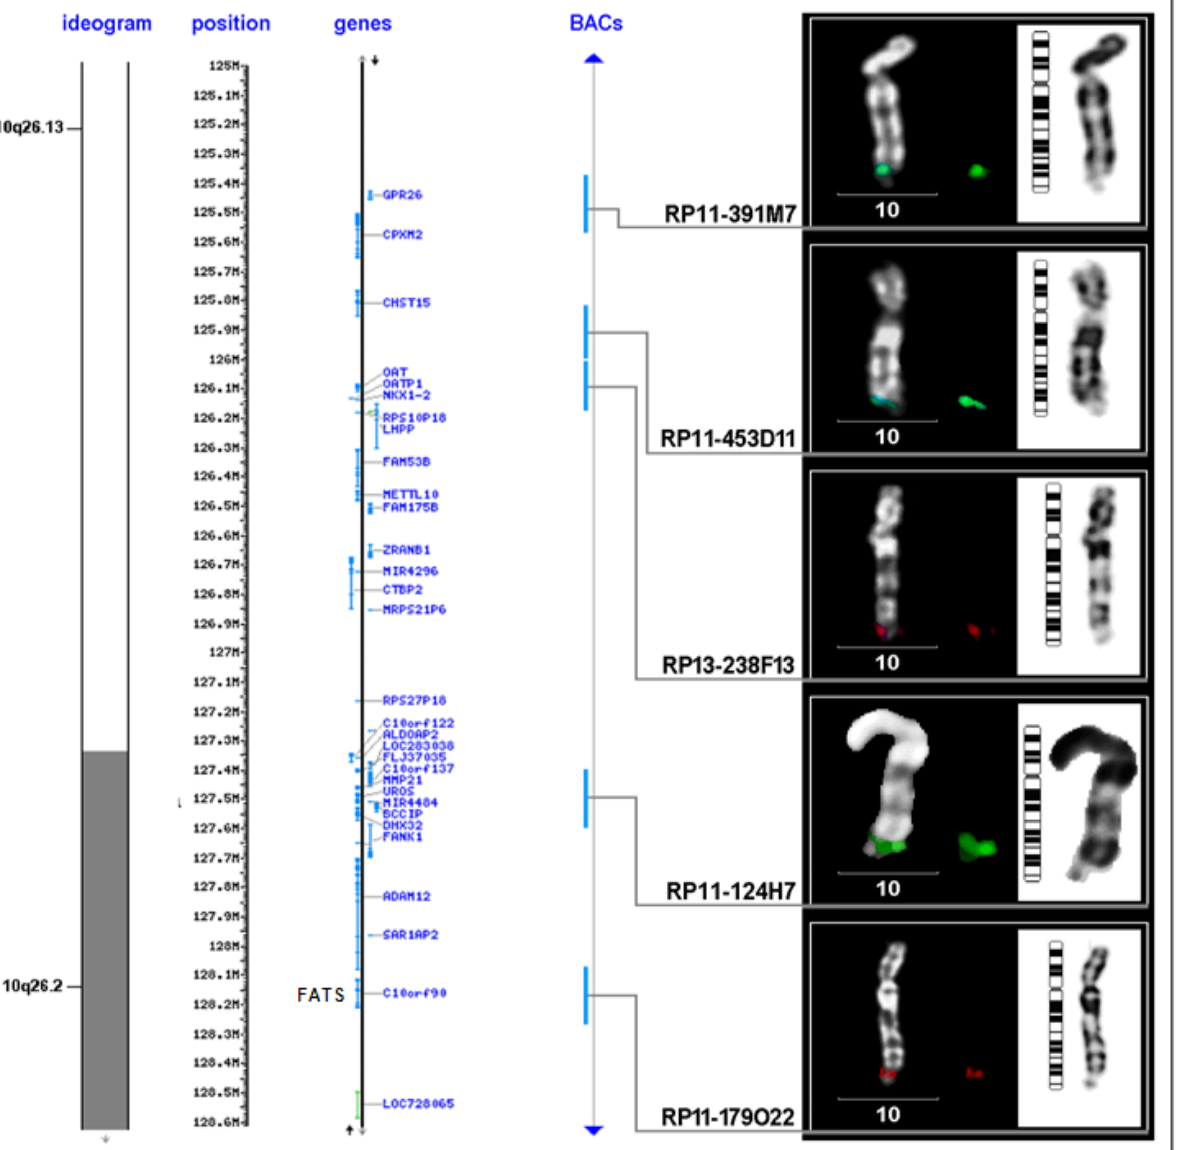
Figure 2. Mapping of FRA10F by FISH. The indicated BAC DNA was labeled and subjected to FISH analysis. The associated genes including FATS ( C10orf90 ) are shown. Lymphocyte cultures were established from 1 mL of peripheral whole blood and 9 mL of RPMI 1640 medium (GIBCO) supplemented with 10% fetal bovine serum. After incubation at 37 °C for 48 h, aphidicolin solution was added (final concentration: 0.2 µM). Cell harvest and metaphase preparations followed routine cytogenetic techniques, and chromosomes were identified by DAPI (Sigma) staining. For each individual, chromosomal breakages/gaps were scored from 500 metaphases, captured and marked by coordinates using a metaphase finder. Images were obtained using a Zeiss Axioplan2 fluorescence microscope equipped with an IMAC CCD camera. FISH, fluorescence in situ